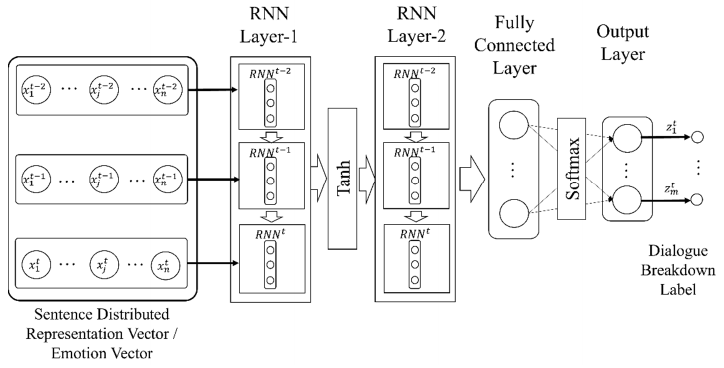
Figure 6. RNN network using sentence vector or emotion vector as feature.